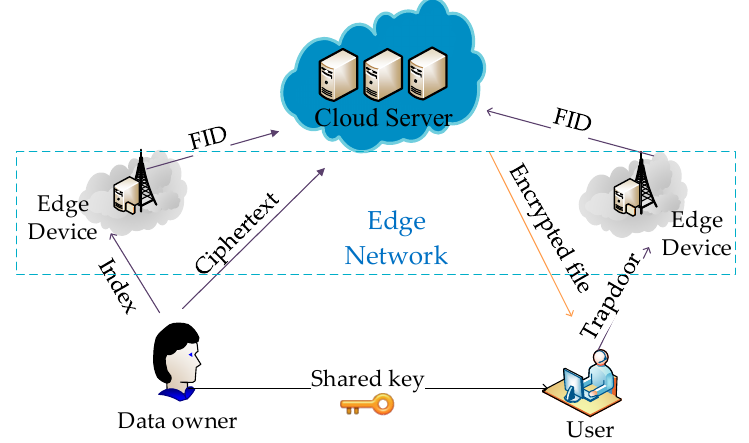
Figure 4. System model of retrieval construction in Edge computing system.